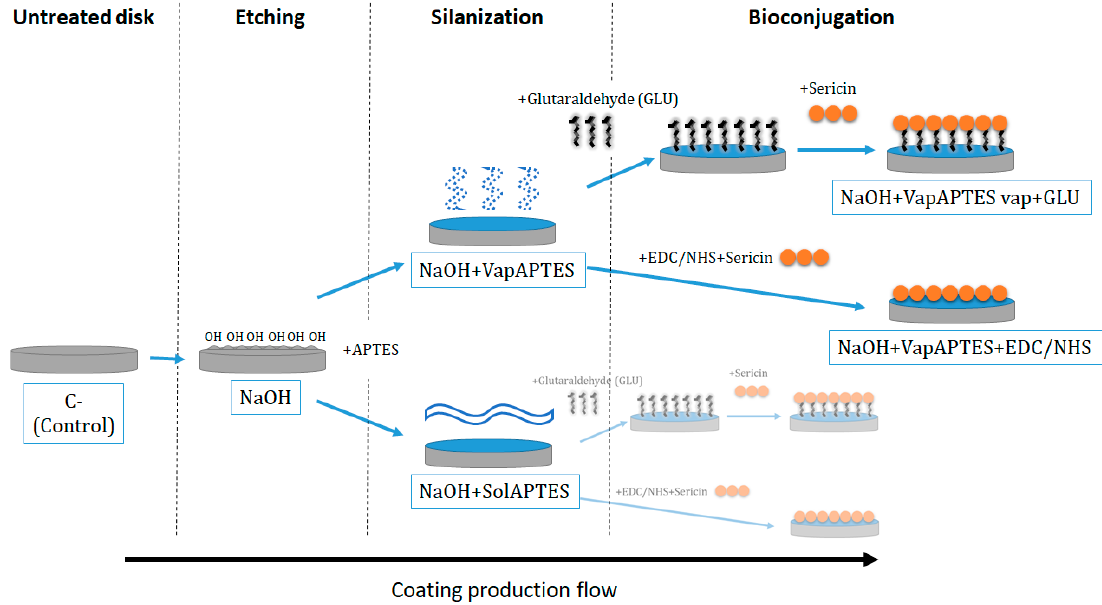
Figure 1. Diagram of the four investigated coating strategies obtained by combining different silanization (vapor-phase deposition (VapAPTES) or organic/aqueous solvent (SolAPTES)) and bio conjugations (glutaraldehyde (GLU) or carbodiimide/N-Hydroxy-succinimide (EDC/NHS)) process after a preliminary etching phase (NaOH).